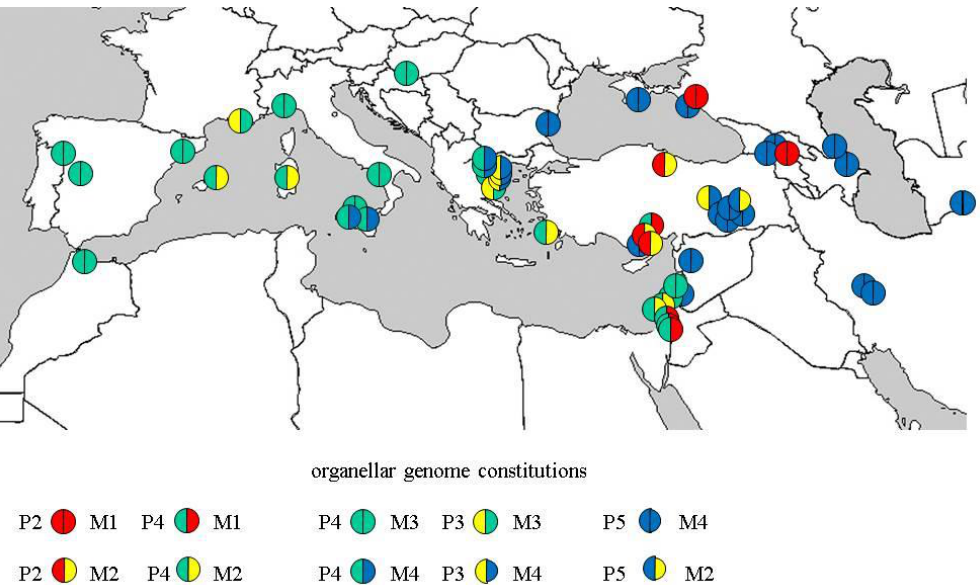
Figure 6. Geographic distribution of organellar genome constitutions of the P. sativum subsp. elatius accessions sequenced in this and the previous [2] study. The left half of a circle indicates plastid clades P2, P3, P4 and P5 coloured in red, yellow, green or blue, respectively; the right half indicates mitochondrial clade M1, M2, M3 and M4 coloured in the same sequence .